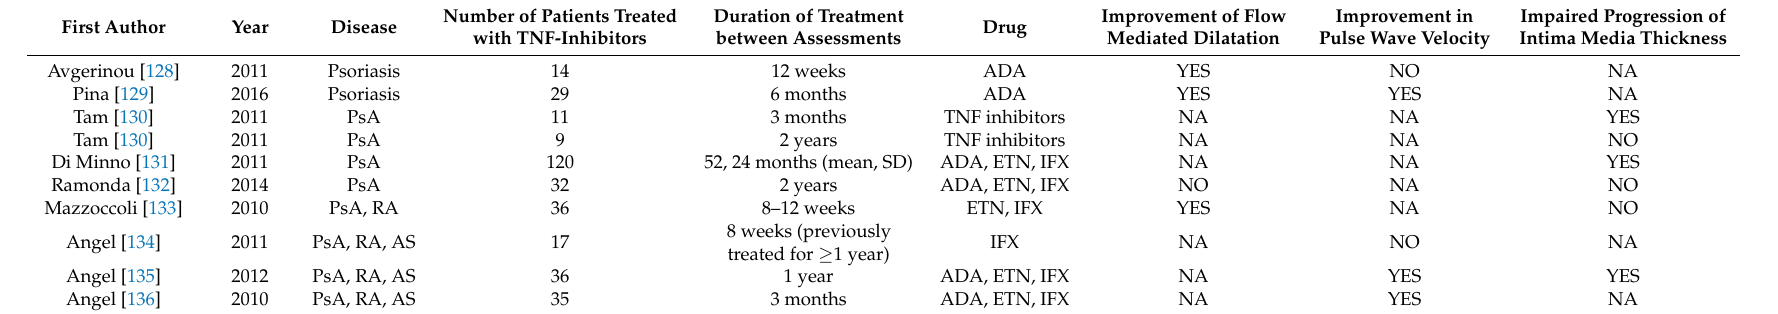
Table 1. TNF inhibitors and endothelial function in patients with psoriasis and